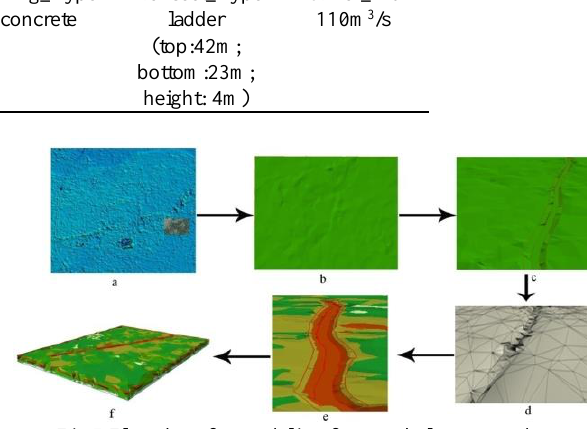
Fig.5 Flowchart for modeling features below